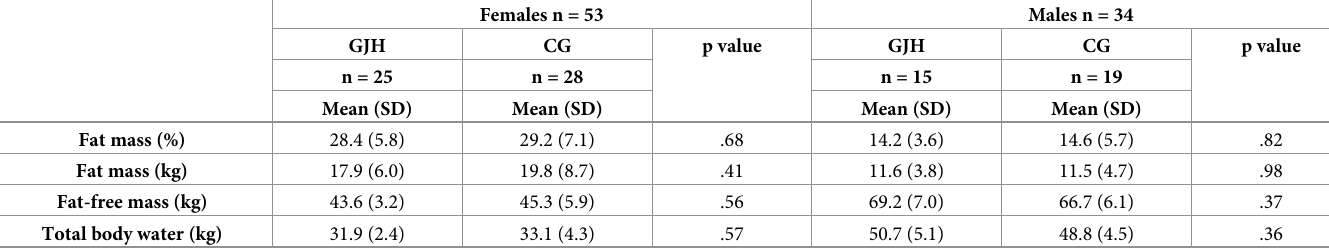
Table 2. The comparison of body compositions between females and males with and without generalized joint hypermobility.